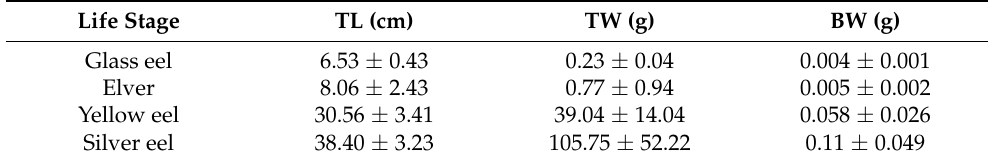
Table 1. Biometrics of sampled eels. Mean total length (TL), mean total weight (TW), and brain weight (BW) of sampled eels ( ± standard deviation) for different life